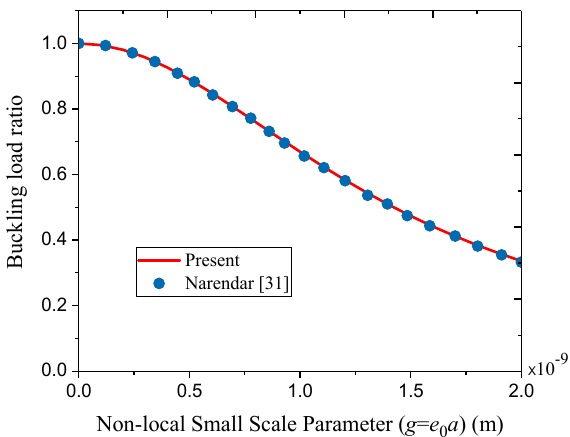
Figure 2. Variation of buckling load ratio with a non-local small-scale parameter for a rectangular homogeneous nanoplate ( m = n = 1, a = 10 nm, b = 5 nm).